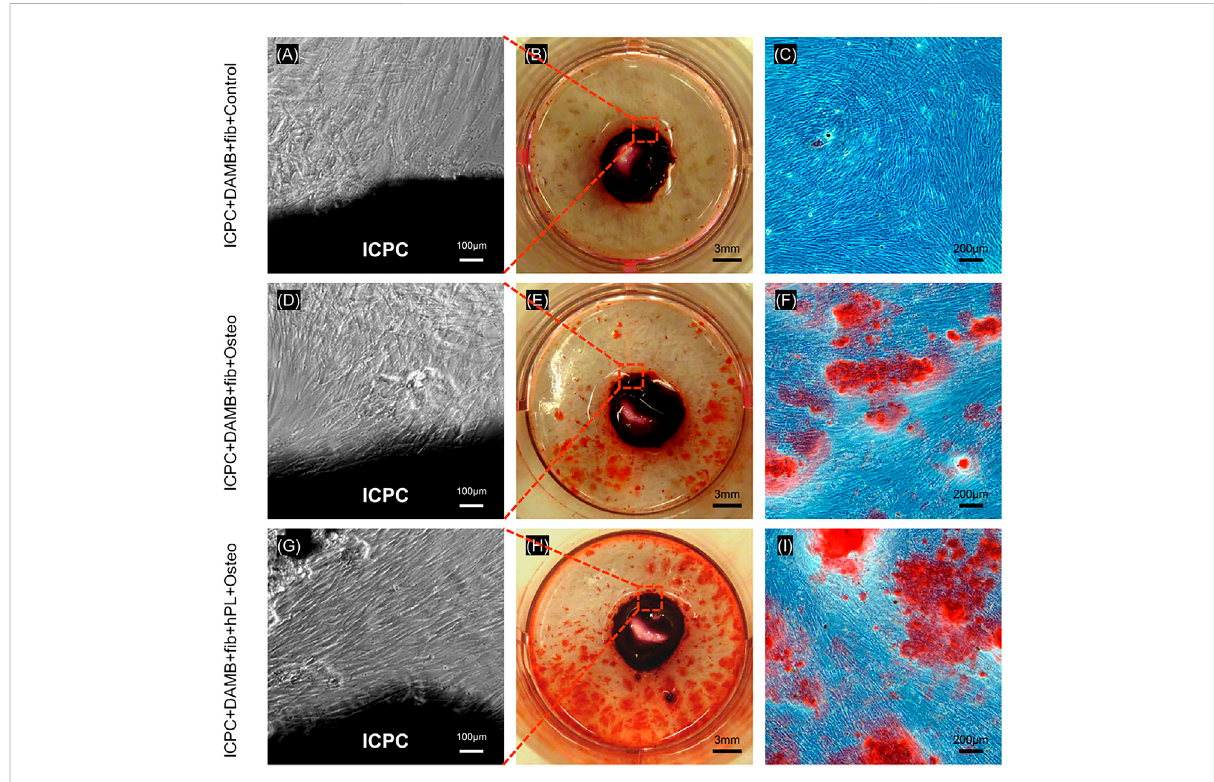
FIGURE 6 hPDLSCs showedhigh proliferation inICPC for21 days (A,D,G) . Representative ARSstaining images ofmineralsynthesis byhPDLSCswithICPC (B,E,H) . Representative imagesofmineralized nodules formedby thehPDLSCs. Moremineralized noduleswere present intheICPC+ DAMB + fi brin + hPL + osteo group than in ICPC + DAMB + fi brin + FBS + osteo group and control group (C,F,I)